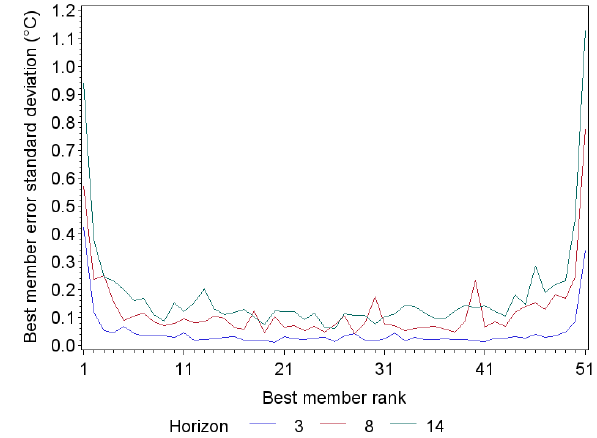
Fig. 4. Best member error ( (cid:15) ∗ t ) standard deviation, w.r.t. best member rank ( k ∗ t ), for 3 horizons: 3, 8 and 14 days.